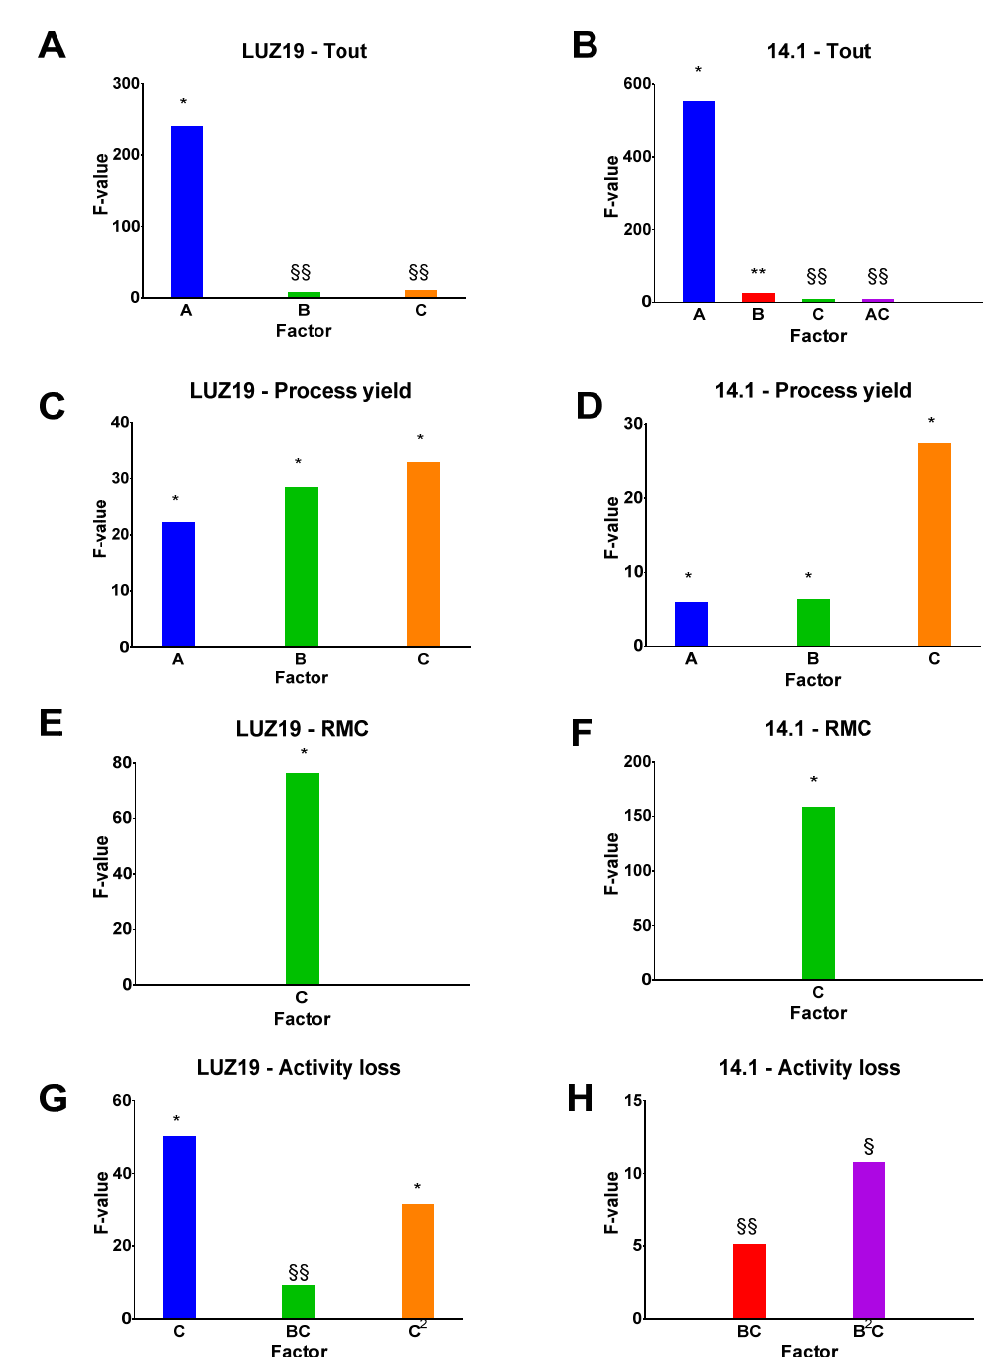
Figure 2. Bar plots showing F-values and associated p -values determining the statistical significance of the main effects and interactions for the response: ( A ) Outlet temperature (Tout) for the LUZ19 process; ( B ) Tout for the 14-1 process; ( C ) Process yield for the LUZ19 process; ( D ) Process yield for the 14-1 process; ( E ) Residual Moisture Content (RMC) for the LUZ19 process; ( F ) RMC for the 14-1 process; ( G ) Activity loss for the LUZ19 process; and ( H ) Activity loss for the 14-1 process. Only terms with p -values equal to or less than 0.05 were plotted. *, p < 0.0001; **, p < 0.001; §, p < 0.005; §§, p < 0.05. Factors: A: Main effect: Tin; B Main effect: Spray gas flow; C: Main effect: L-isoleucine concentration; BC: Two-factor interactions: Spray gas flow and L-isoleucine concentration; C2: Quadratic term modelling curvature of an ellipse in the response surface for L-isoleucine concentration; B2C: Cubic terms modelling inflected asymmetry for Spray gas flow and L ‐ isoleucine concentration.